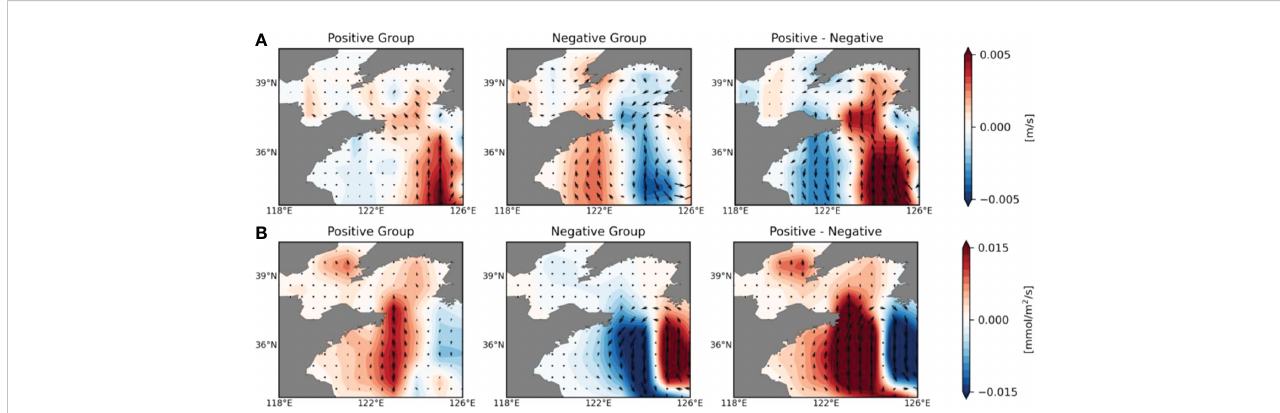
FIGURE 3 (A) Shading indicates the ensemble mean of the surface (upper 30 m depth mean) meridional ocean current velocity difference between historical and future climate periods for the positive group and negative group (excluding GFDL-ESM4) and the difference between the two groups. Vectors show future changes in surface zonal and meridional ocean current velocities in the YECS region. (B) Ensemble mean of differences in the vertically integrated (upper 100 m depth) meridional PO 4 transport (shading) between historical and future climate periods for the positive group [Left Panel] and negative group [Middle Panel] (excluding GFDL-ESM4) and the difference between the two groups [Right Panel]. Vectors indicate vertically integrated zonal and meridional